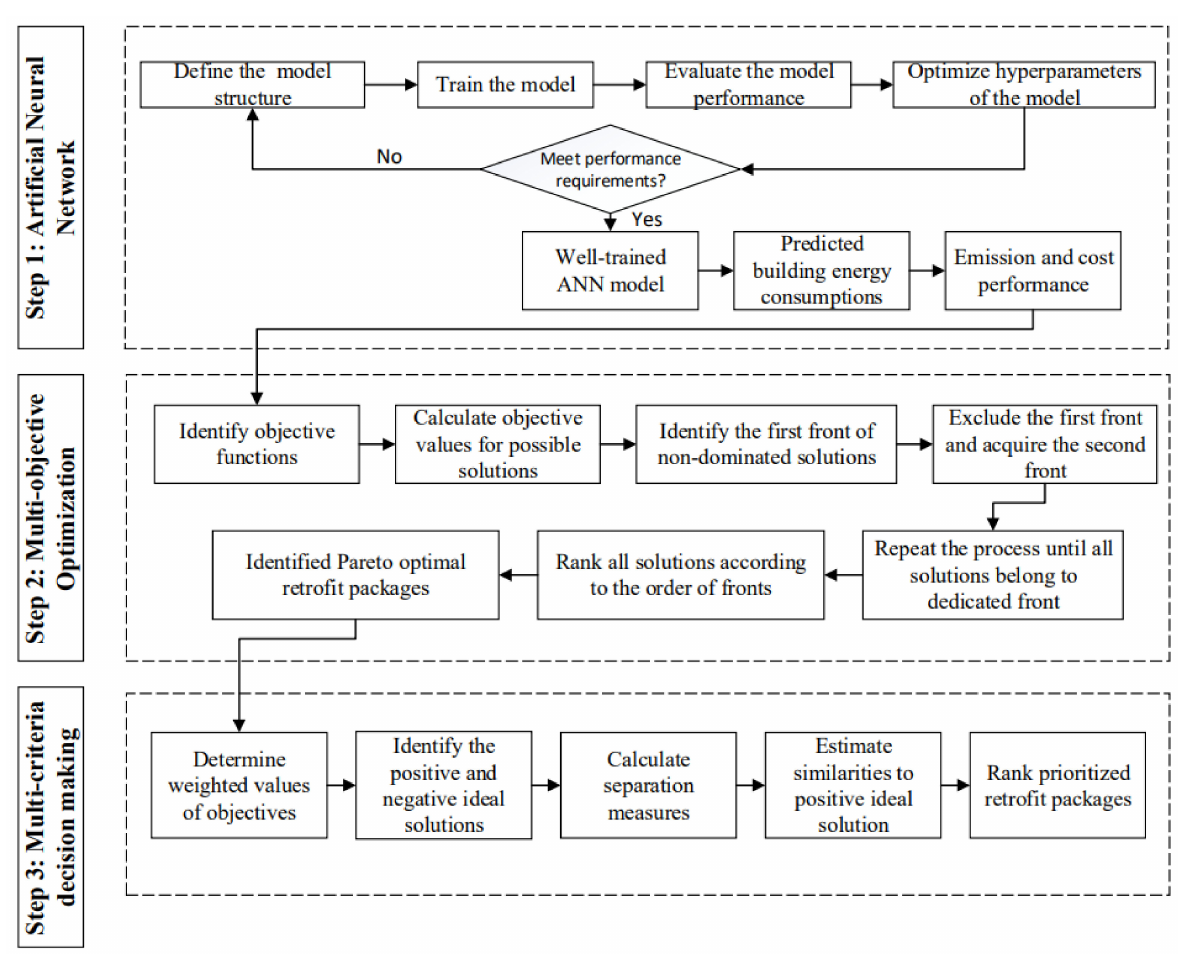
Figure 1. The overall methodology of the